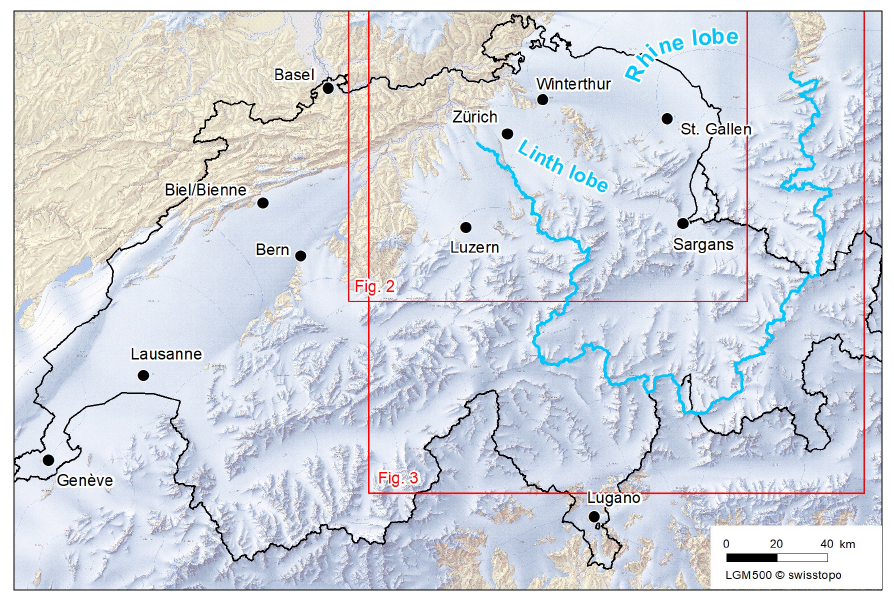
Figure 1. Map of Swiss Alps at the LGM showing maximum extent of ice cover (from Bini et al., 2009) with outline of Rhine glacier basin in blue. Source: Bundesamt für Landestopografie swisstopo. Outlines of Figs. 2 and 3 are shown in